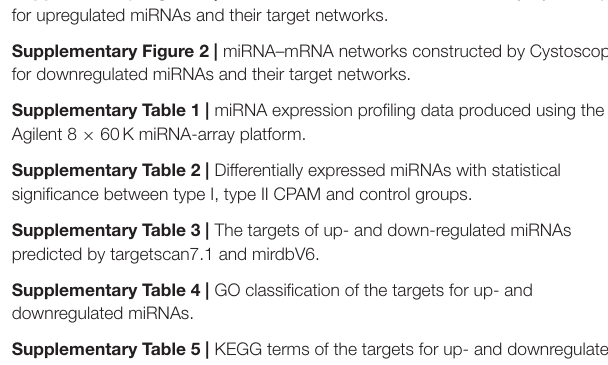
Supplementary Figure 1 | miRNA–mRNA networks constructed by Cystoscope for upregulated miRNAs and their target networks. Supplementary Figure 2 | miRNA–mRNA networks constructed by Cystoscope for downregulated miRNAs and their target networks.